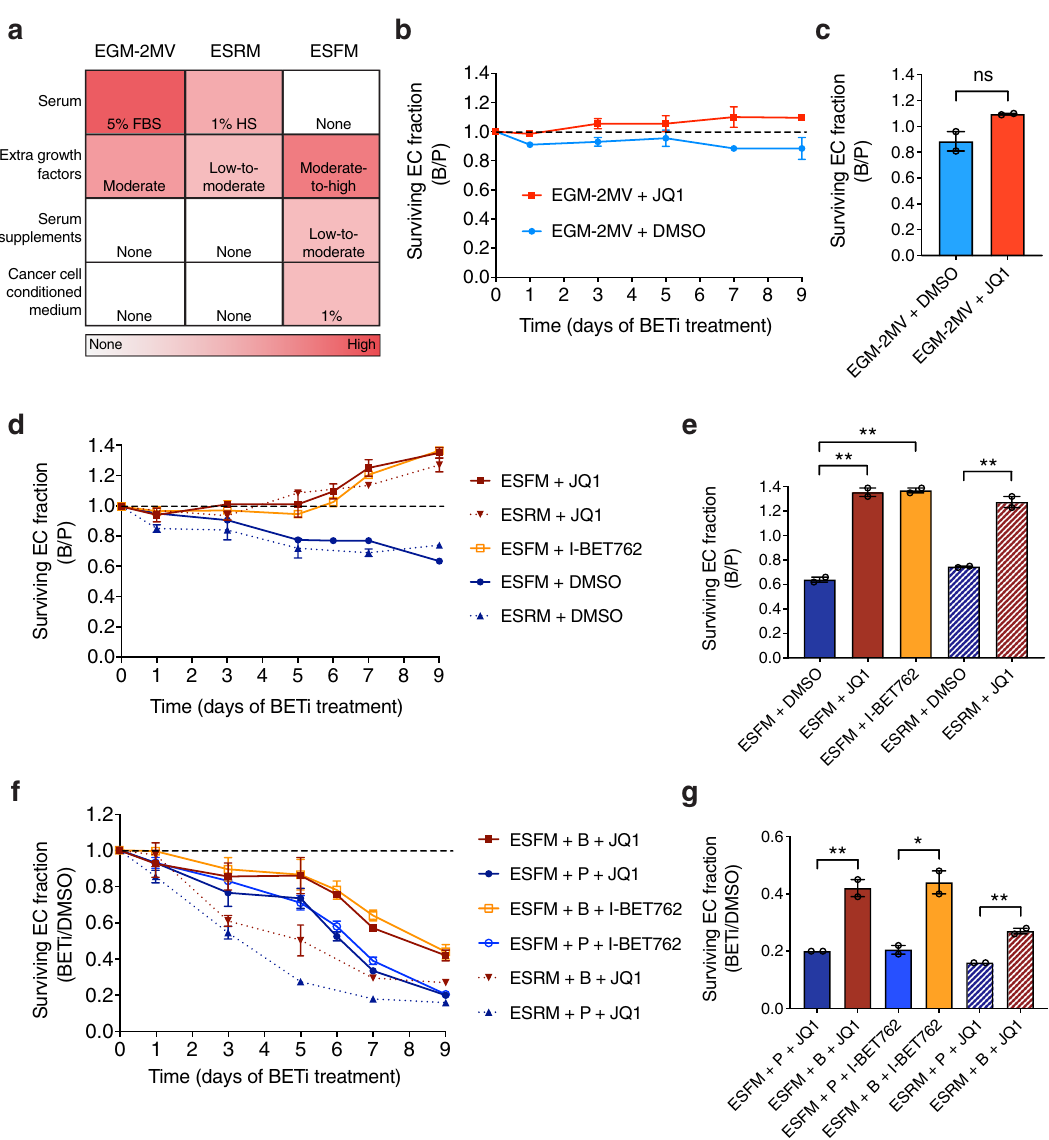
Fig. 5 Mitigating interaction between BETi and bevacizumab in ECs. a Characteristics of VEGFA-independent (EGM-2MV) and VEGFA-dependent (ESRM and ESFM) culture conditions. FBS, fetal bovine serum; HS, human serum. b , c Relative cell response to bevacizumab in EGM-2MV plus DMSO or JQ1 during days 0 – 9 ( b ) or on day 9 ( c ): JQ1 did not change EC response to bevacizumab under VEGFA-independent conditions. d , e Relative cell response to bevacizumab in ESFM or ESRM plus DMSO or BETi during days 0 – 9 ( d ) or on day 9 ( e ): BETi reversed EC sensitivity to bevacizumab under VEGFA- dependent conditions. f , g Relative cell response to BETi in ESFM or ESRM plus palivizumab or bevacizumab during days 0 – 9 ( f ) or on day 9 ( g ): bevacizumab attenuated survival- and/or proliferation-inhibiting effect(s) of BETi under VEGFA-dependent conditions. A ratio of 1 (black dotted line) indicates no effect on survival and/or proliferation of ECs. Error bars represent ± SEM ( n = 2 independent experiments). * P value < 0.05; ** P value < 0.01; *** P value < 0.001; **** P value < 0.0001; ns, not signi fi cant (two-tailed unpaired t